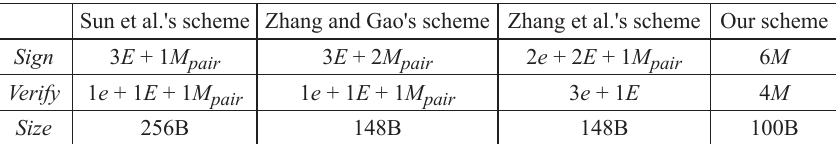
Performance comparisons of different